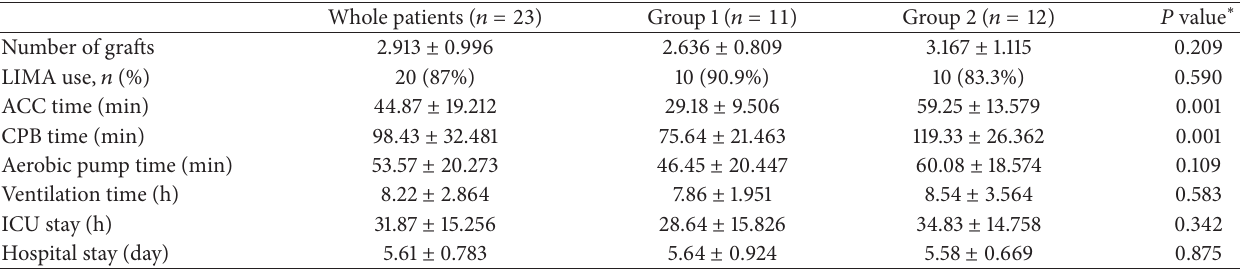
Table 2: Perioperative variables of